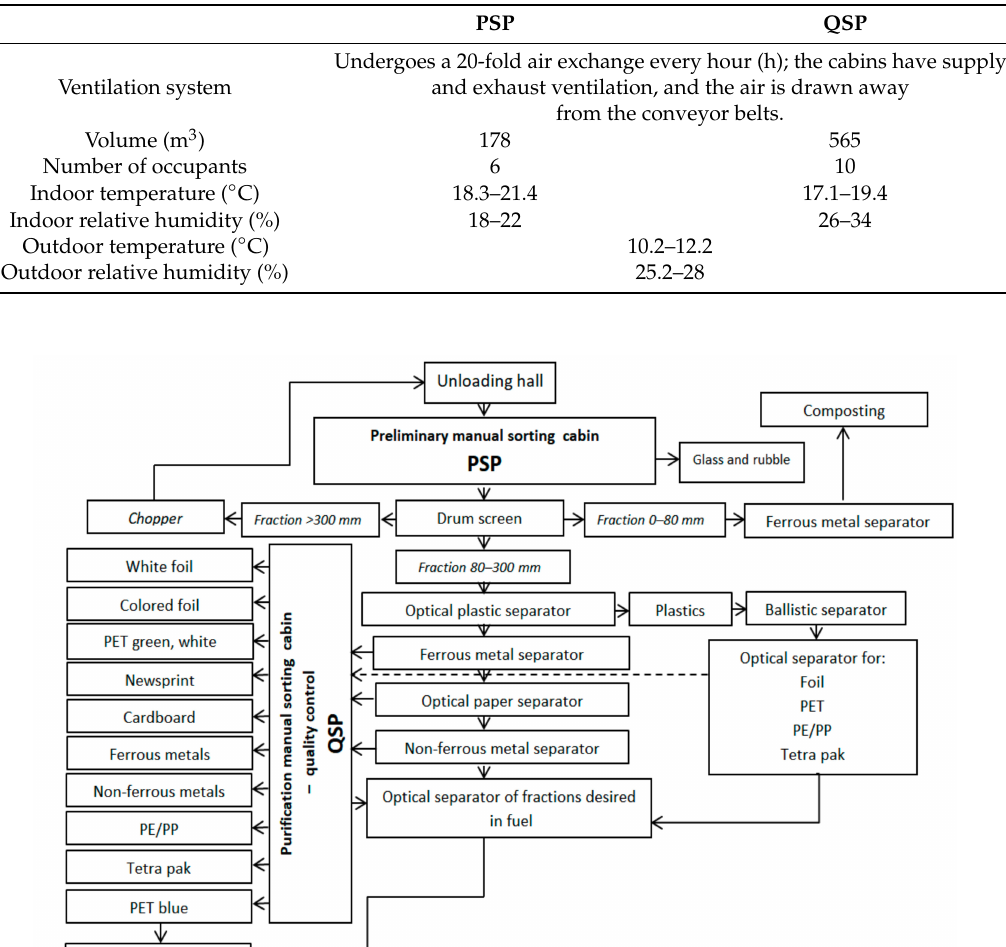
Table 1. Environmental parameters and basic description of the two cabins: preliminary manual sorting cabin (PSP) and purification manual sorting cabin (quality control; QSP) at the waste-sorting plant (WSP).